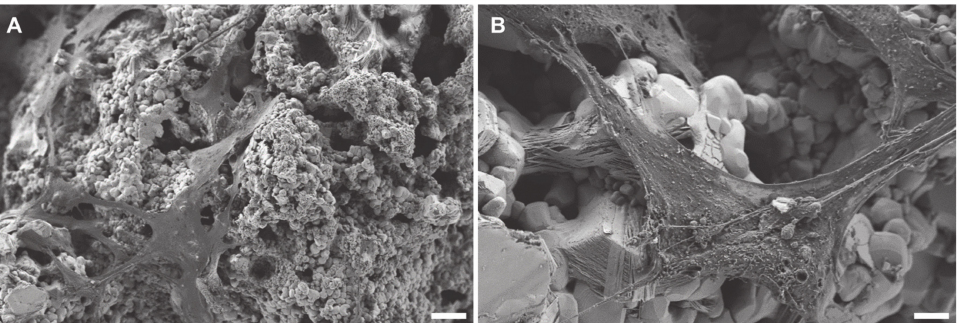
Figure 11. SEM images of MC3T3-E1 cells after 24 h of incubation on BaTiO 3 / HA sca ff olds. Representative SEM images of MC3T3-E1 cell-material interaction with BaTiO 3 / HA substrates. Scale bars: 20 µ m ( A ), 4 µ m ( B ).